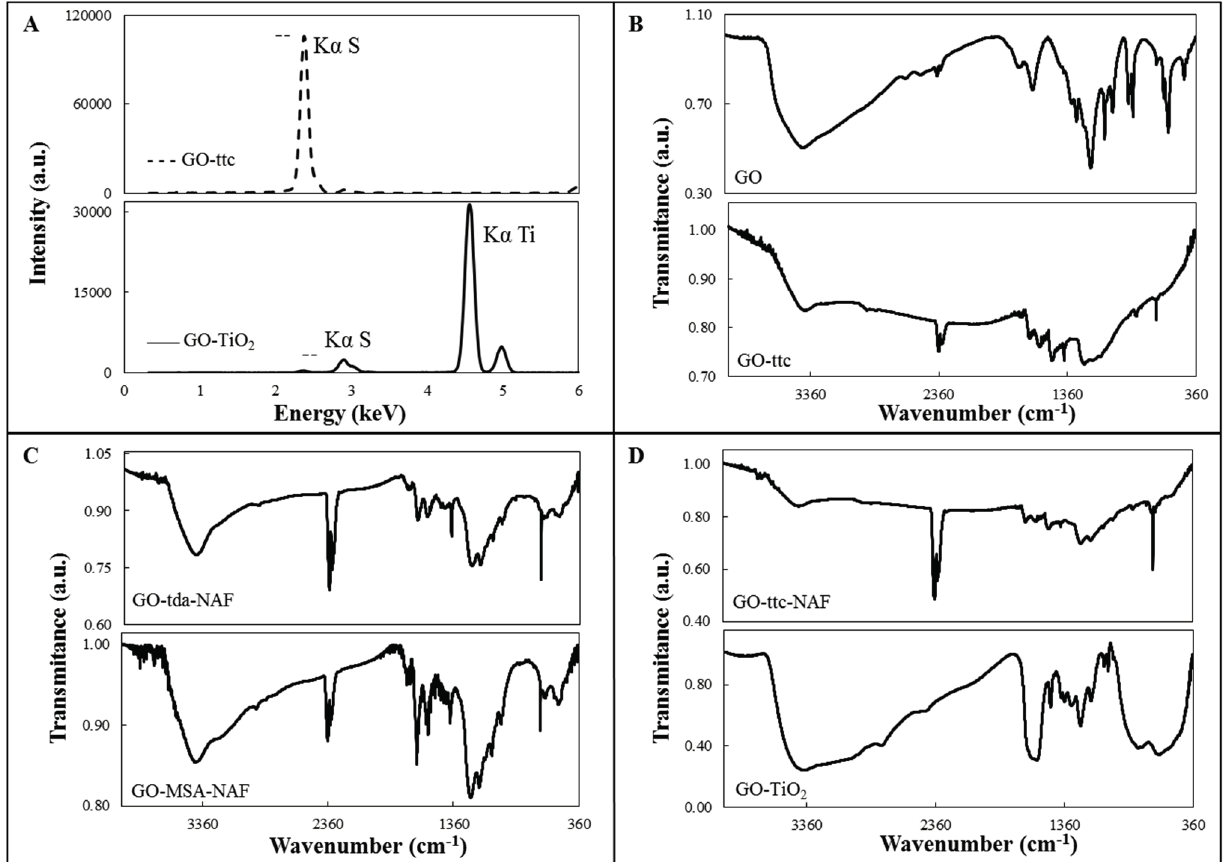
Figure 2. Characterization of graphene oxide modified materials. ( A ) XRF analysis of GO-ttc (dashed line) and GO-TiO 2 (solid line); ( B – D ) IR spectra of studied